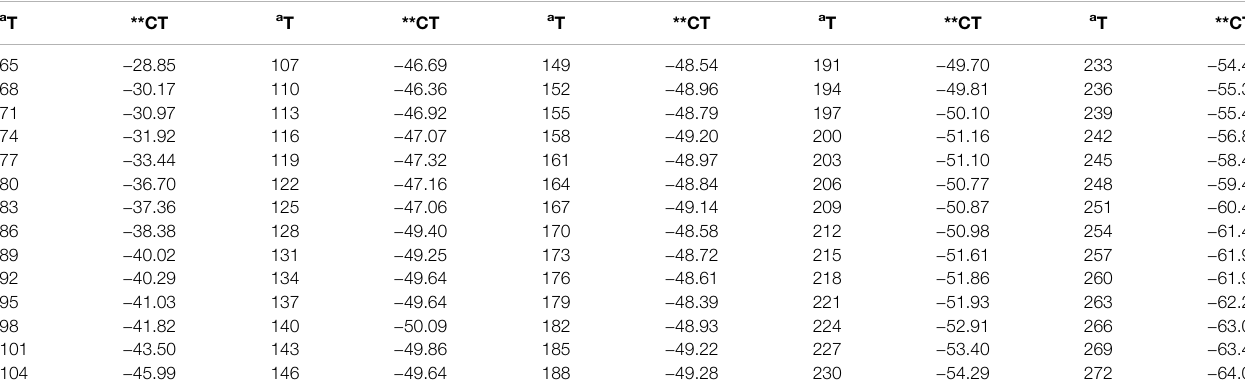
TABLE 6 | Second-stage monitoring values of a measuring point in Zhanshan Station.